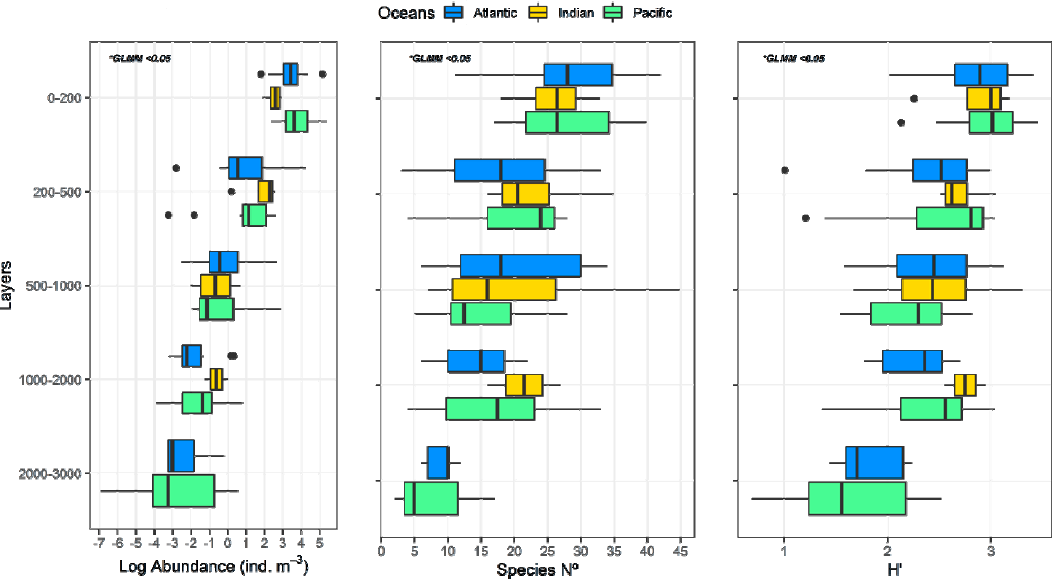
Figure 6. Box plots showing the distribution of copepod abundance (log-transformed) as ind · m − 3 , number of species and diversity (H’ as Shannon index) at the five depth layers (m) sampled in the Atlantic, Pacific, and Indian Oceans (averaged stations). The central line in the boxes represents the median, the boxes extend from the 25% to 75% percentiles, and the whiskers encompass 95% of the data. Values beyond these limits are shown as closed circles.